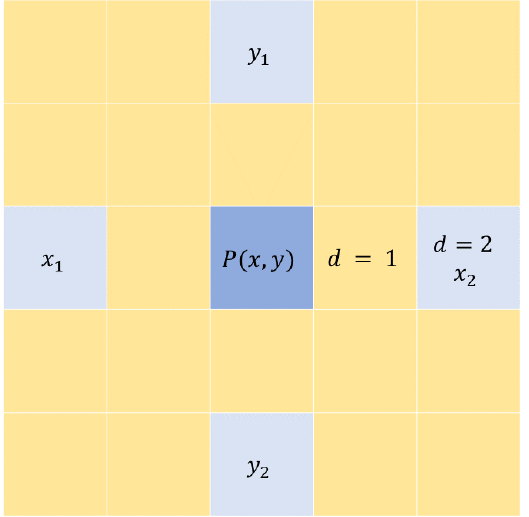
Figure 1. The GLCM matrix is calculated for center pixel P(x,y) using the pixels at d = 2.